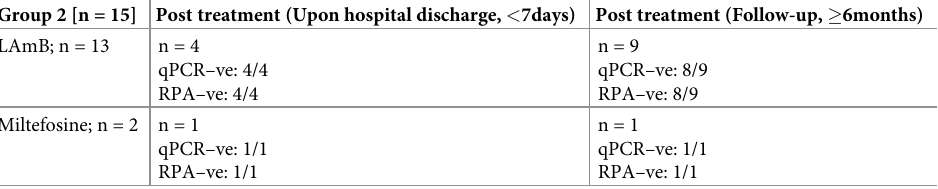
Table 4. Performance analysis of qPCR and RPA assays for VL following completion of treatment. Group 2 [n = 15] Post treatment (Upon hospital discharge, < 7days) Post treatment (Follow-up, � 6months) LAmB; n =